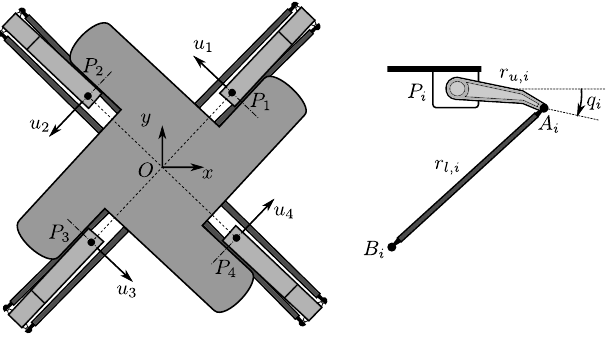
Figure 2. Notation used in the model of the parallel